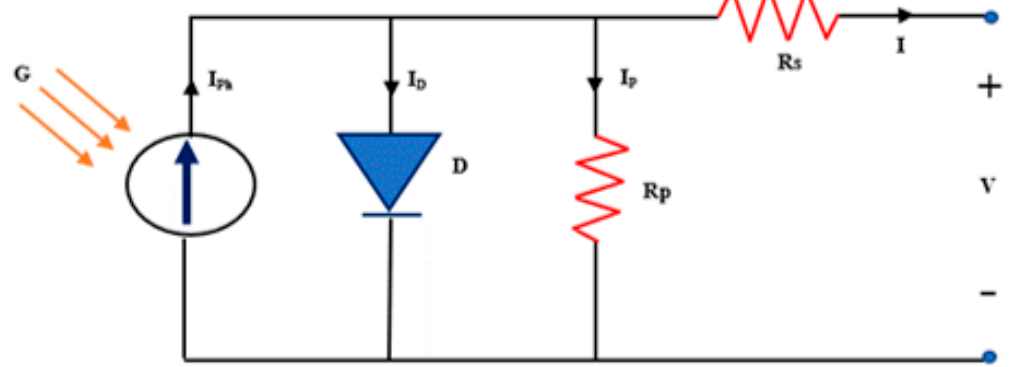
Figure 2. Solar cell of a single-diode electrical circuit.